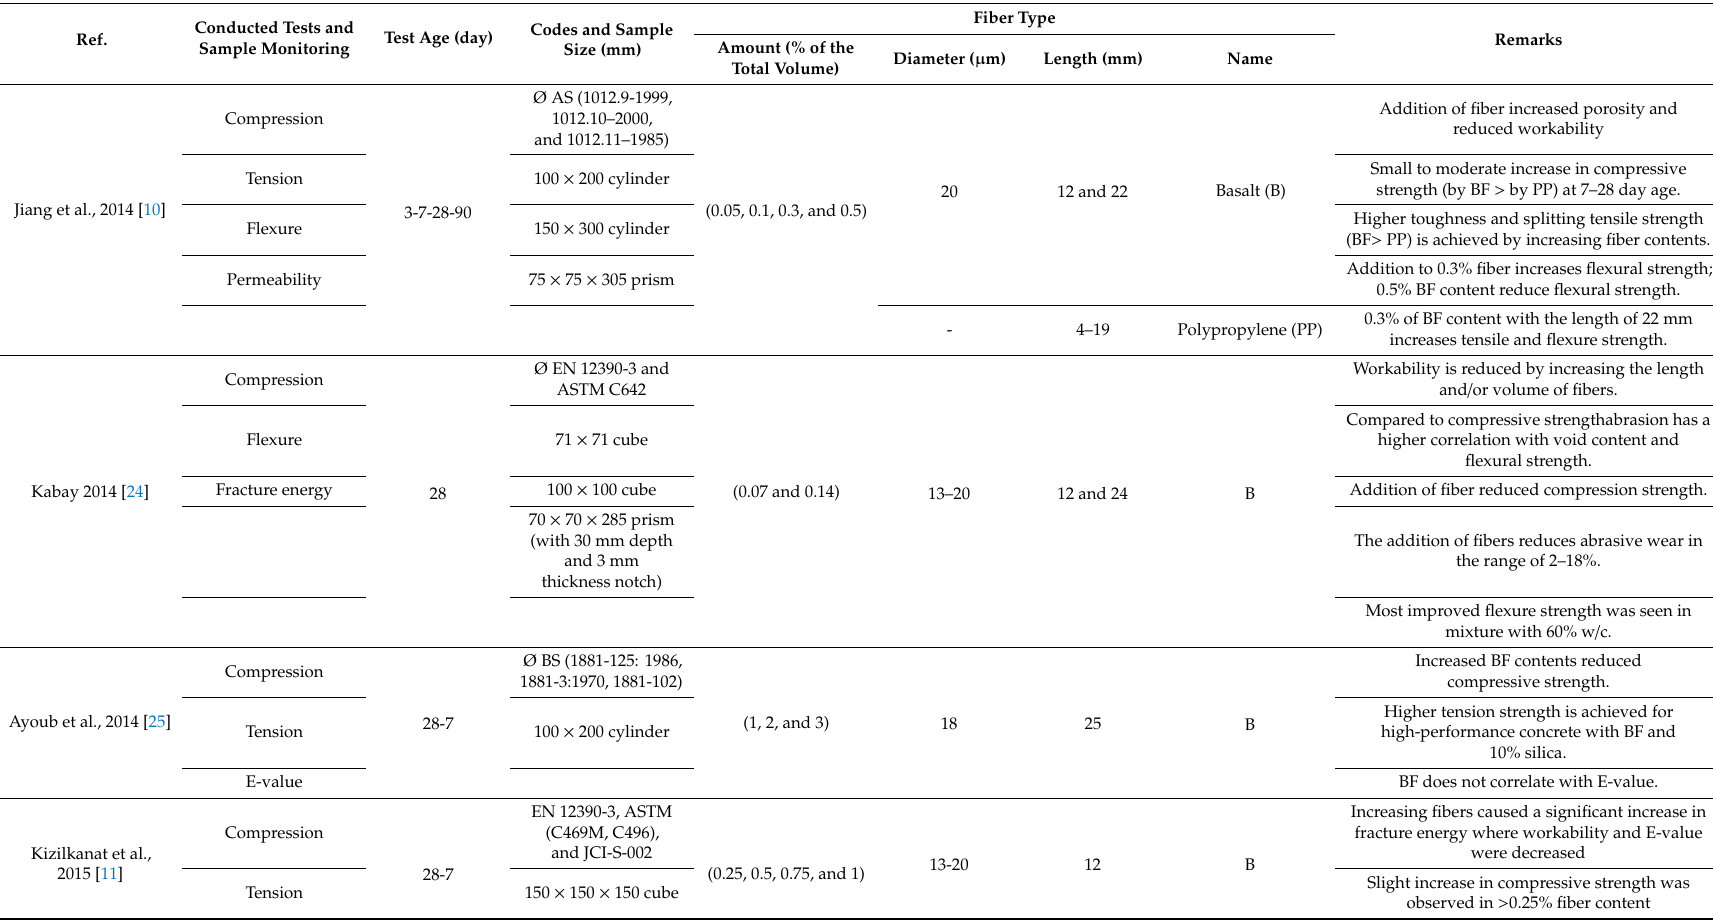
Table 1. Cement concrete with